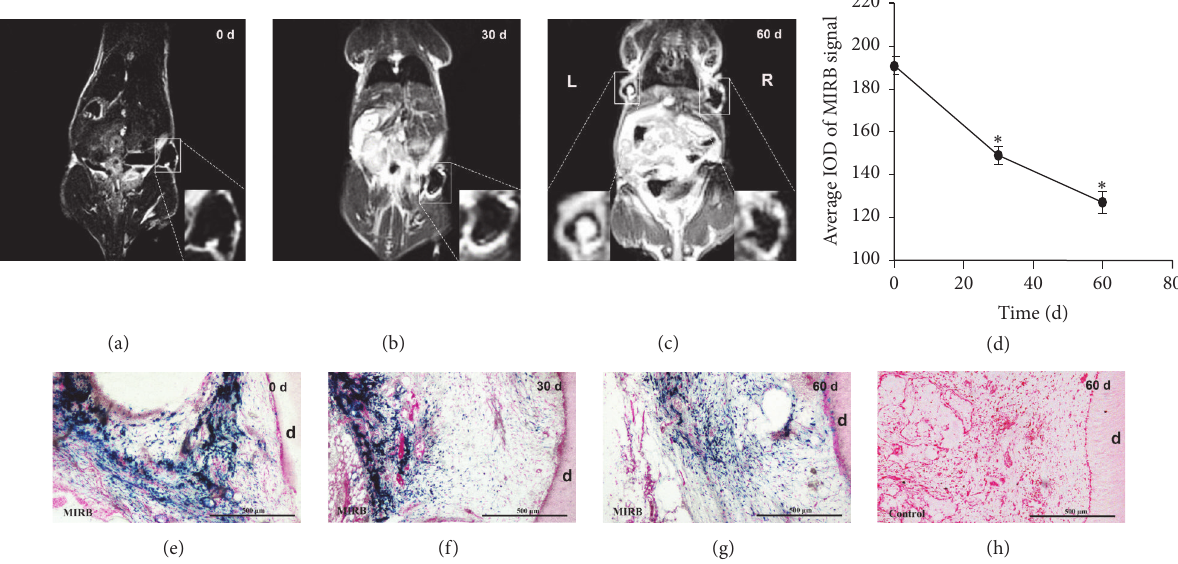
Figure 7: MRI and histological examination of MIRB-labeled hDPSCs cell sheets/root fragments complex in vivo. (a) In vivo MR images of nude mice immediately after transplantation. (b) In vivo MR images of nude mice 30 days after transplantation. (c) In vivo MR images of nude mice 60 days after transplantation. Left boxed area indicates the unlabeled cell sheets (high signal image) and right boxed area indicates the labeled cell sheets. (d) Quantification analysis of the signal intensity of MIRB from the boxed area of (a), (b), and (c). ∗ 𝑃 < 0.05 . (e) Prussian blue staining of the MIRB-labeled group immediately after transplantation. (f) Prussian blue staining of the MIRB-labeled group 30 days after transplantation. (g) Prussian blue staining of the MIRB-labeled group 60 days after transplantation. (h) Prussian blue staining of the control group 60 days after transplantation. The scale bar of (e–h) indicates 500 𝜇